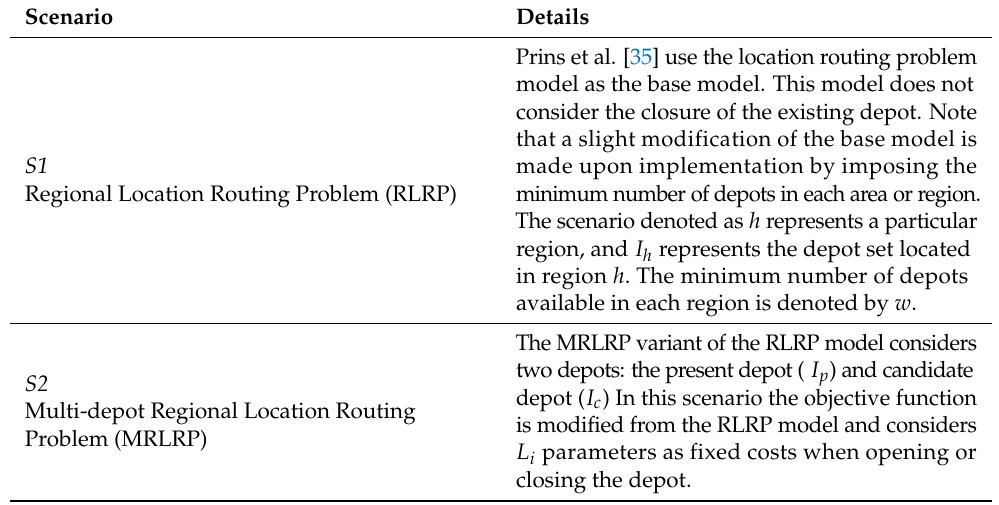
Figure 1. Illustration of scenario 1 and scenario 2. Table 1.